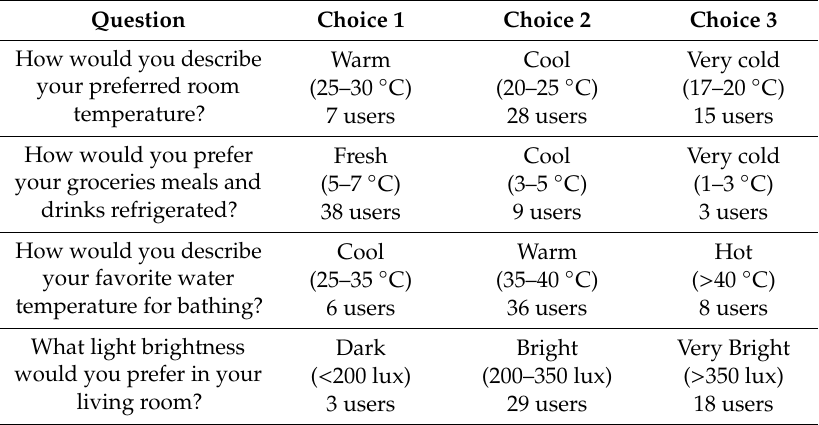
Table 2. Household appliance user preference